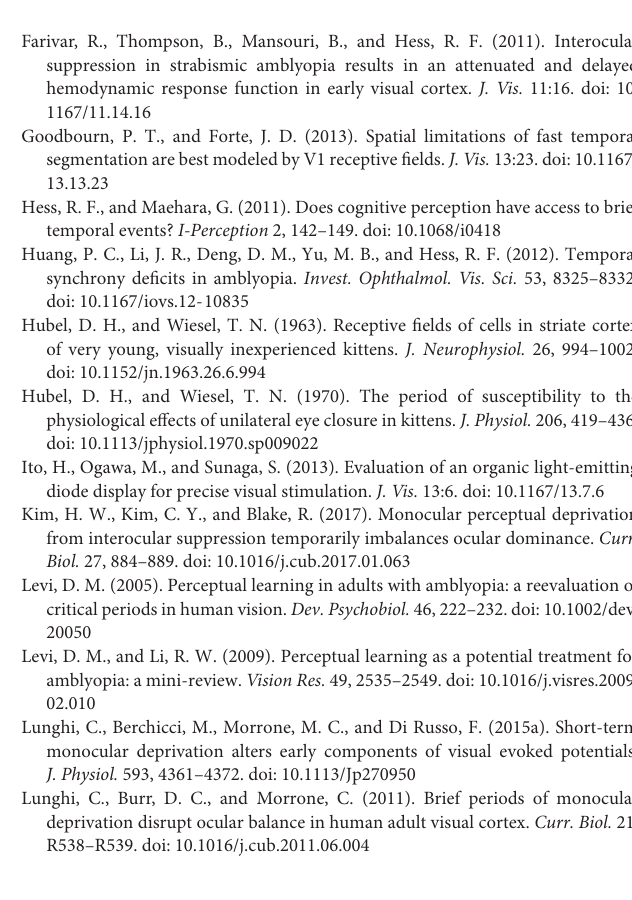
FIGURE S1 | The temporal characteristics for the CRT and OLED monitor. (A,B) The temporal response function (TRF) for CRT and OLED. (C) The temporal profiles of the stimuli. The solid and dashed lines represent the two stimuli. Two stimuli flickered at 1 Hz and with 100 ms temporal lag. (D,E) The temporal profiles convolved with the TRF by using CRT and OLED. (F) Temporal lags shown in CRT and OLED. Black column denotes temporal lag we set for two stimuli; red one denotes temporal lag when stimuli appear on CRT display; green one denotes temporal lag when stimuli appear on OLED display. DATA SHEET S1 | The datasets generated for this